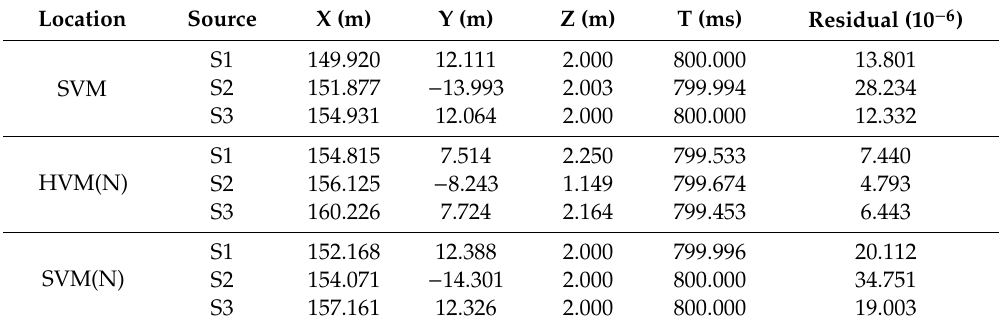
Table 4. Location results of the three comparative experiments. SVM: single-velocity model, HVM: heterogeneous velocity model, (N): Noisy arrival